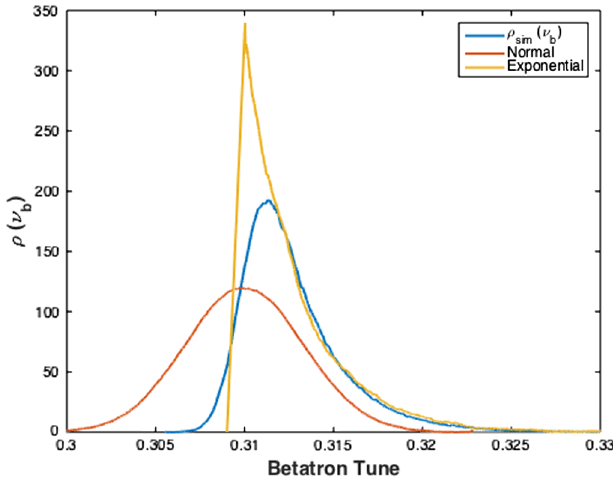
FIG. 12. Betatron tune distributions ρ ð ν 0.003 rms tune spread.